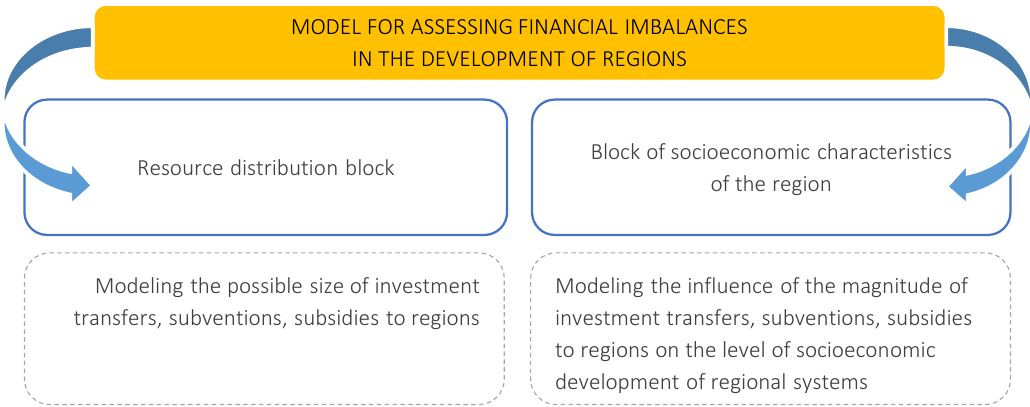
Figure 1. Model for assessing financial imbalances in the development of regions